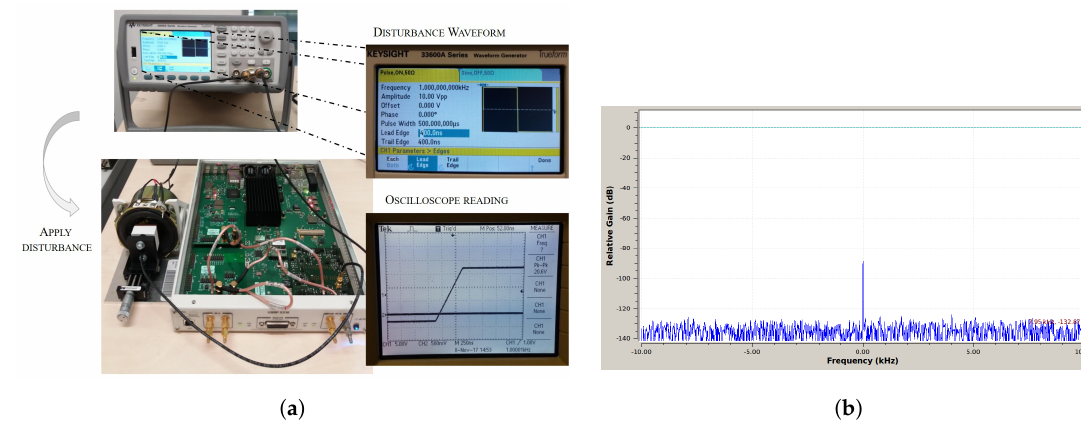
Figure 11. Disturbance evaluation setup and resulting FFT. ( a ) Measurement setup used for the disturbance evaluation. ( b ) FFT of the received signal with disturbance signal applied at the sensor counter